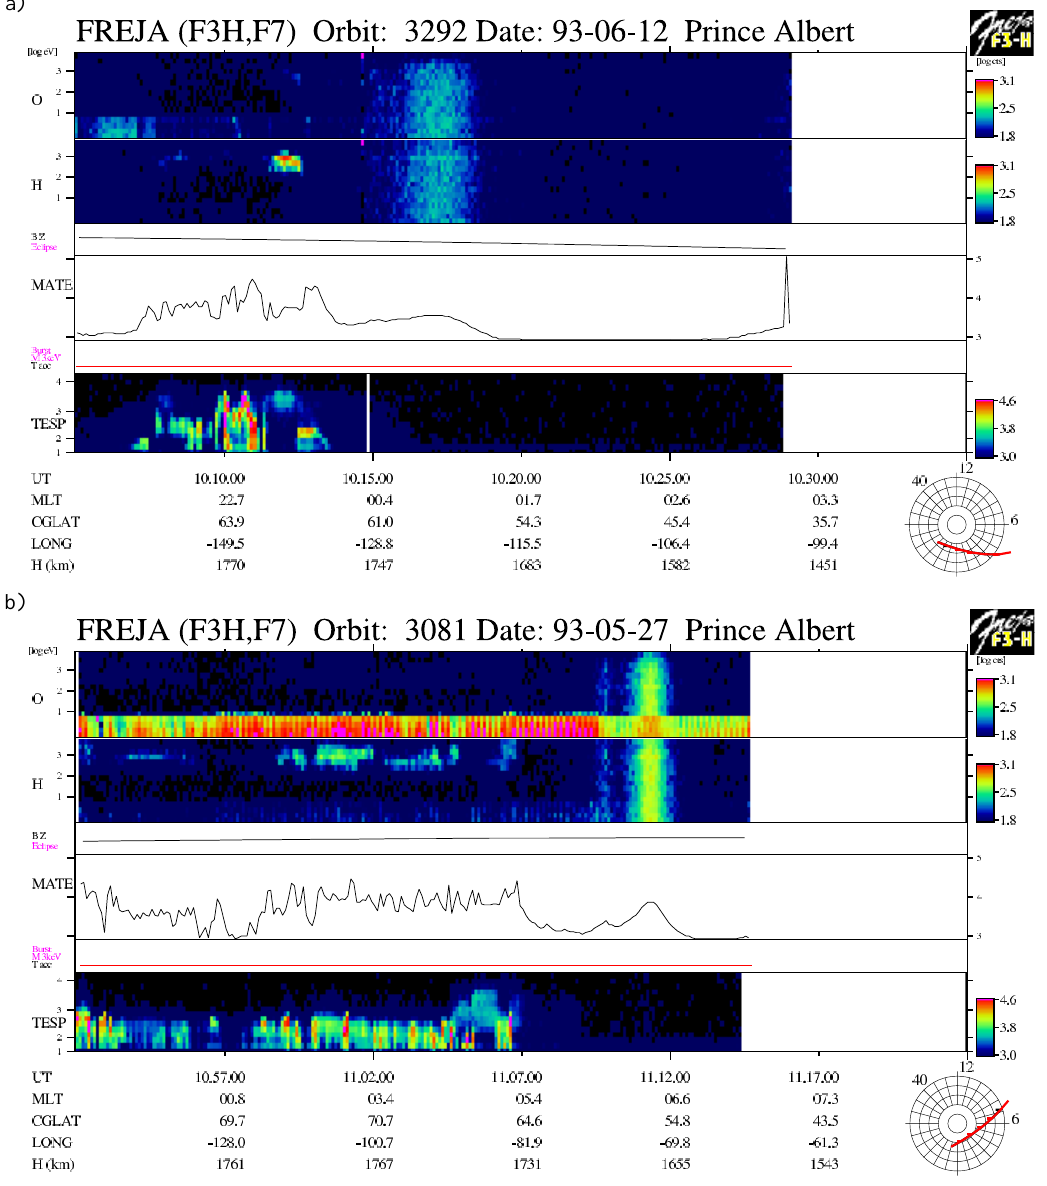
Fig.24. Precipitating ions occur (almost only) in a period when the electron energy spectrum is like an un-accelerated typical plasma sheet spectrum in (a) . In (b) the only major gap in the H + ion precipitation coincides with a period with such a plasma-sheet electron